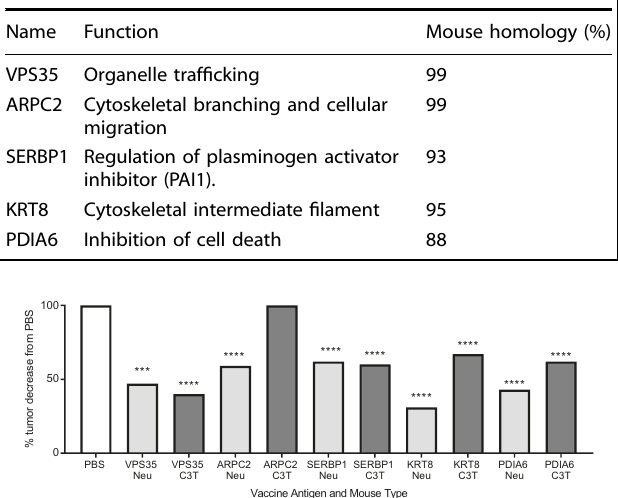
Fig. 3 Vaccination with peptides from candidate antigen ’ s predicted human MHC class II epitopes inhibit tumor growth in transgenic mouse mammary tumor models. Percent decreased tumor growth from TgMMTV-neu (light gray) and C3(1)Tag mice (dark gray) n = 8/group as compared to control PBS vaccinated mice (white). Mice were vaccinated with peptides from VPS35, ARPC2, SERBP1, KRT8, and PDIA6 or PBS with CFA/IFA adjuvant ~14 days for three times and then with 3 × 10 5 syngeneic mouse mammary tumor cells (MMC for TgMMTV-neu and M6 for C3(1)Tag) implanted. **** p <